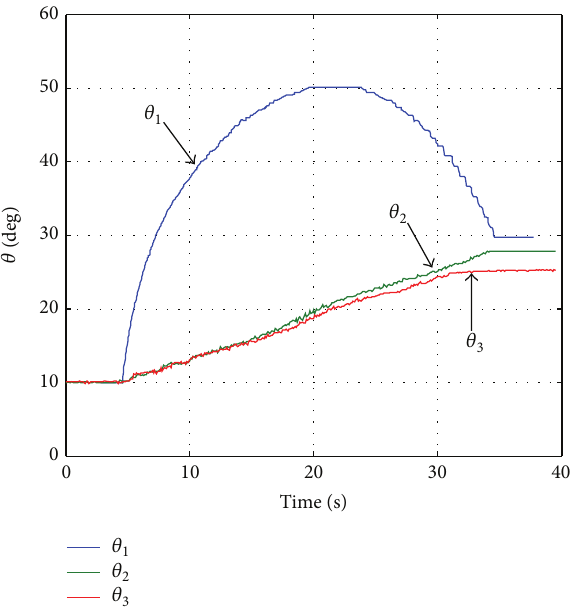
Figure 10: Joints angular optimal displacement (experiment